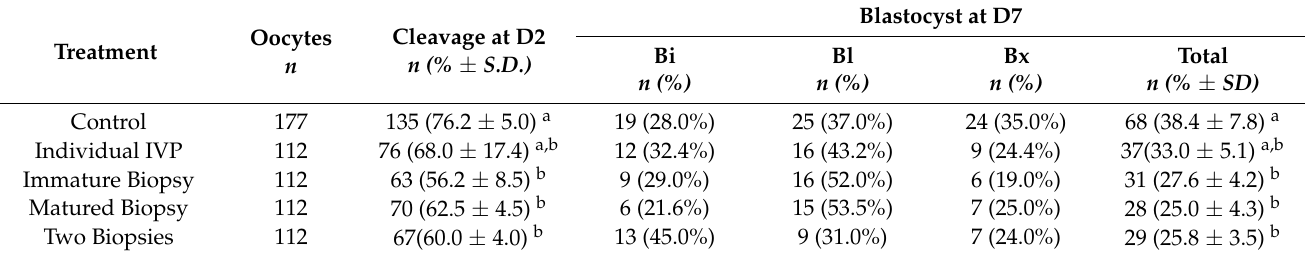
Table 2. Number ( n ) and percentage ± standard deviation (% ± SD) of cleavage (D2) and embryo development (D7). Cumulus oocyte complexes (COCs) were submitted to in vitro maturation, fertilization, and culture in groups (Control), individually (Individual IVP), or individually submitted to cumulus cells (CC) biopsy, before (Immature Biopsy), after (Matured Biopsy), and before and after in vitro maturation (Two